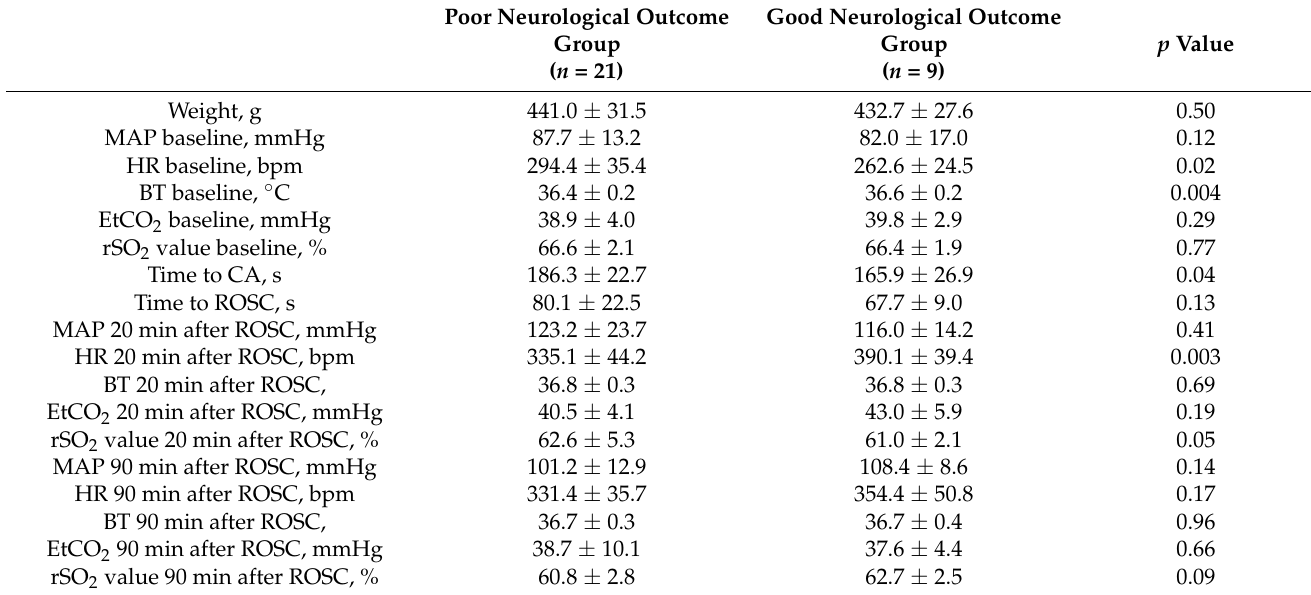
Table 1. Baseline characteristics and perioperative parameters between good and poor neurological outcome groups. Good Neurological Outcome Poor Neurological Outcome Group